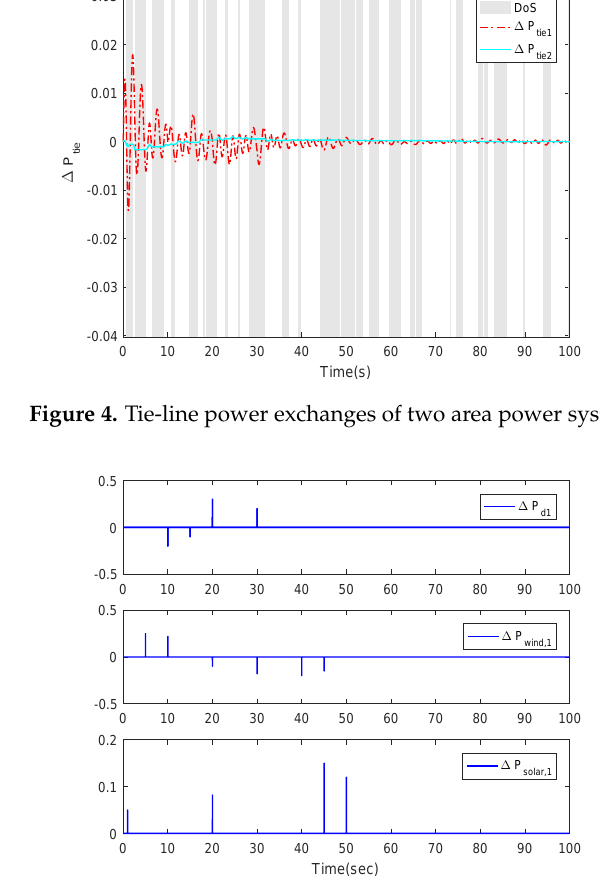
Figure 5. Multi-disturbances in first area power